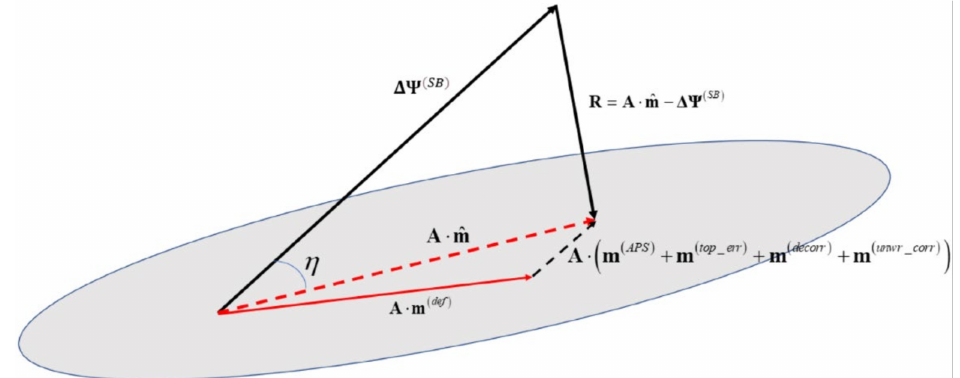
Figure 3. Vectorial representation of the least-squares problem discussed in Equation (4). The grey area identifies the co-domain of the linear transformation given by Equation